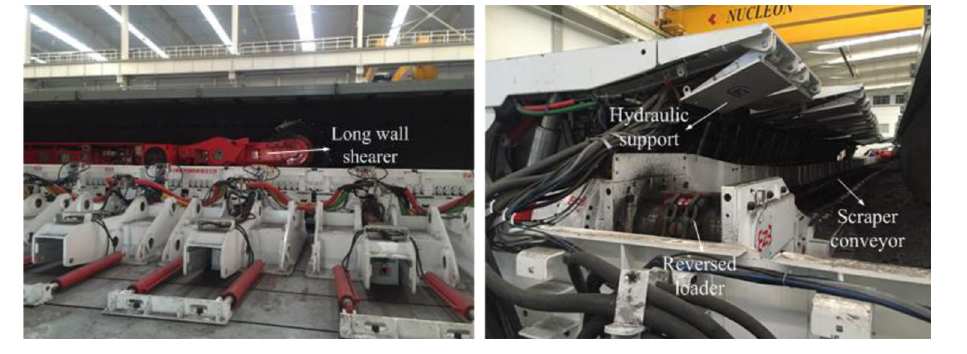
Fig. 1 Fully mechanized coal mining system